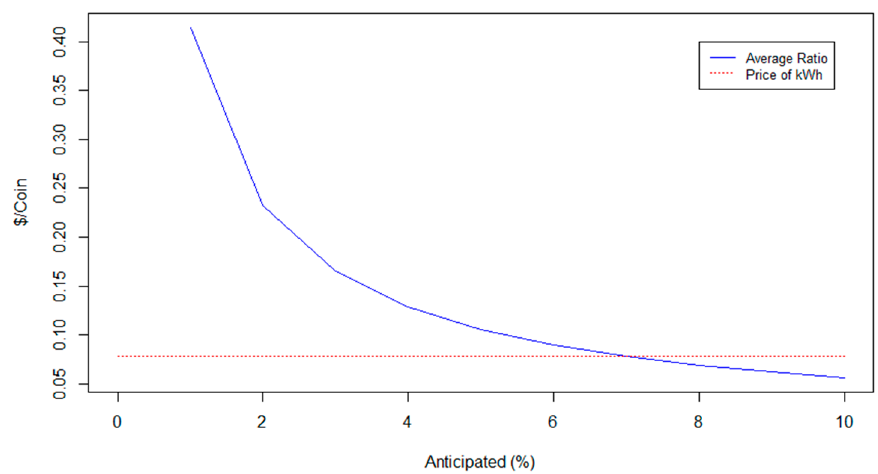
Figure 3. Sensitivity analysis of the ratio according to the percentage of the anticipated savings.